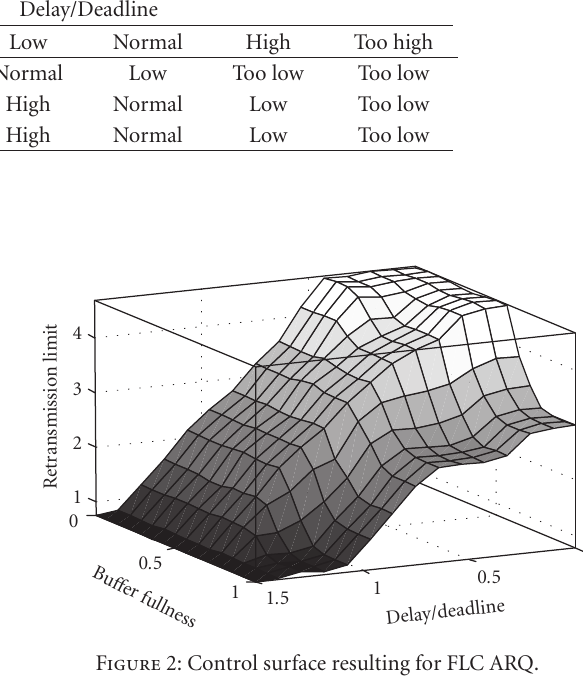
Table 1: FLC If ··· then rules used to identify output fuzzy subsets from inputs. Delay/Deadline Too low